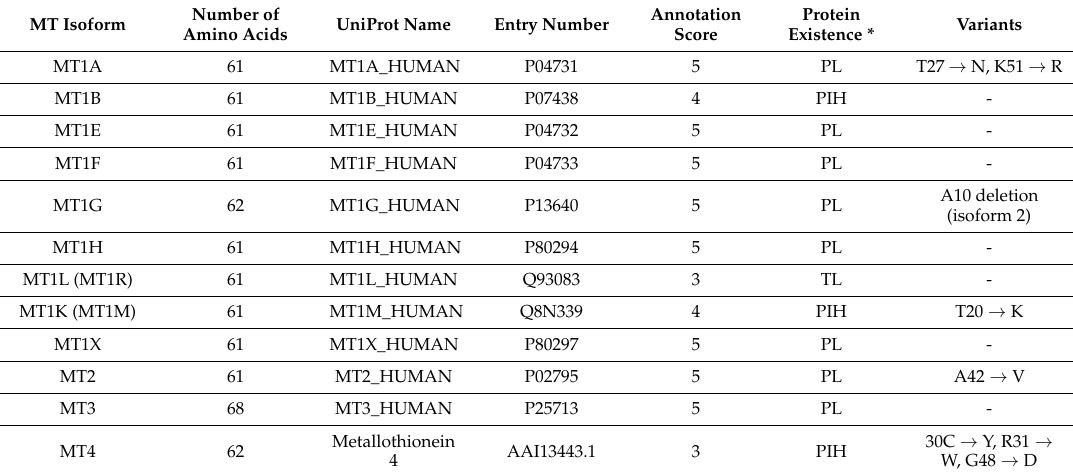
Table 2. Human metallothionien isoforms UniProtKB/Swiss-Prot, annotation score (from 0 to 5), information on protein or transcript level, and natural protein variants. Entry number of MT4 is provided from the NCBI data base due to the wrong protein sequence deposited in UniProt (MT4_HUMAN, P47944), which refers to an MT4 variant (30C → Y, R31 →